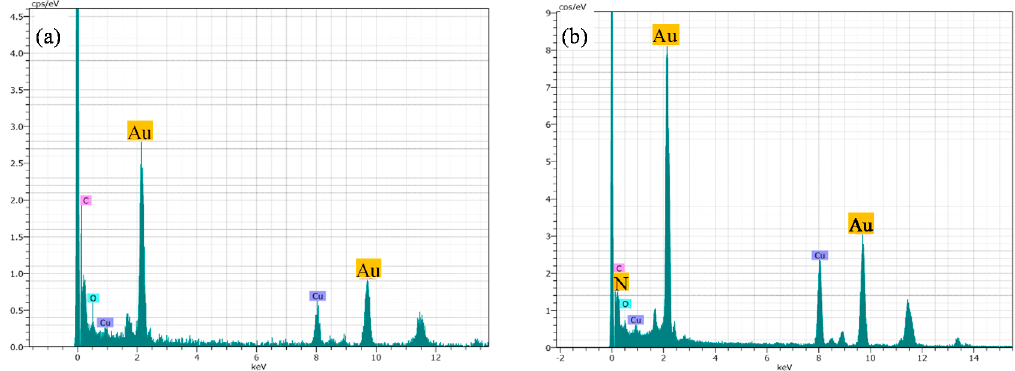
Figure 4. ( a ) EDX analysis of AuNPs confirmed the presence of gold. ( b ) EDX analysis for AuNP–MTX400 confirmed the presence of N as indicator of MTX presence.